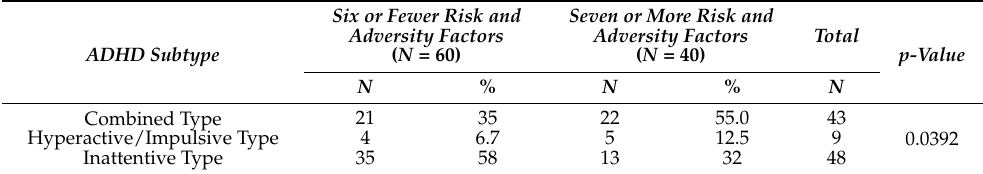
Table 3. Association of number of risk and adversity factors as compared to ADHD type.